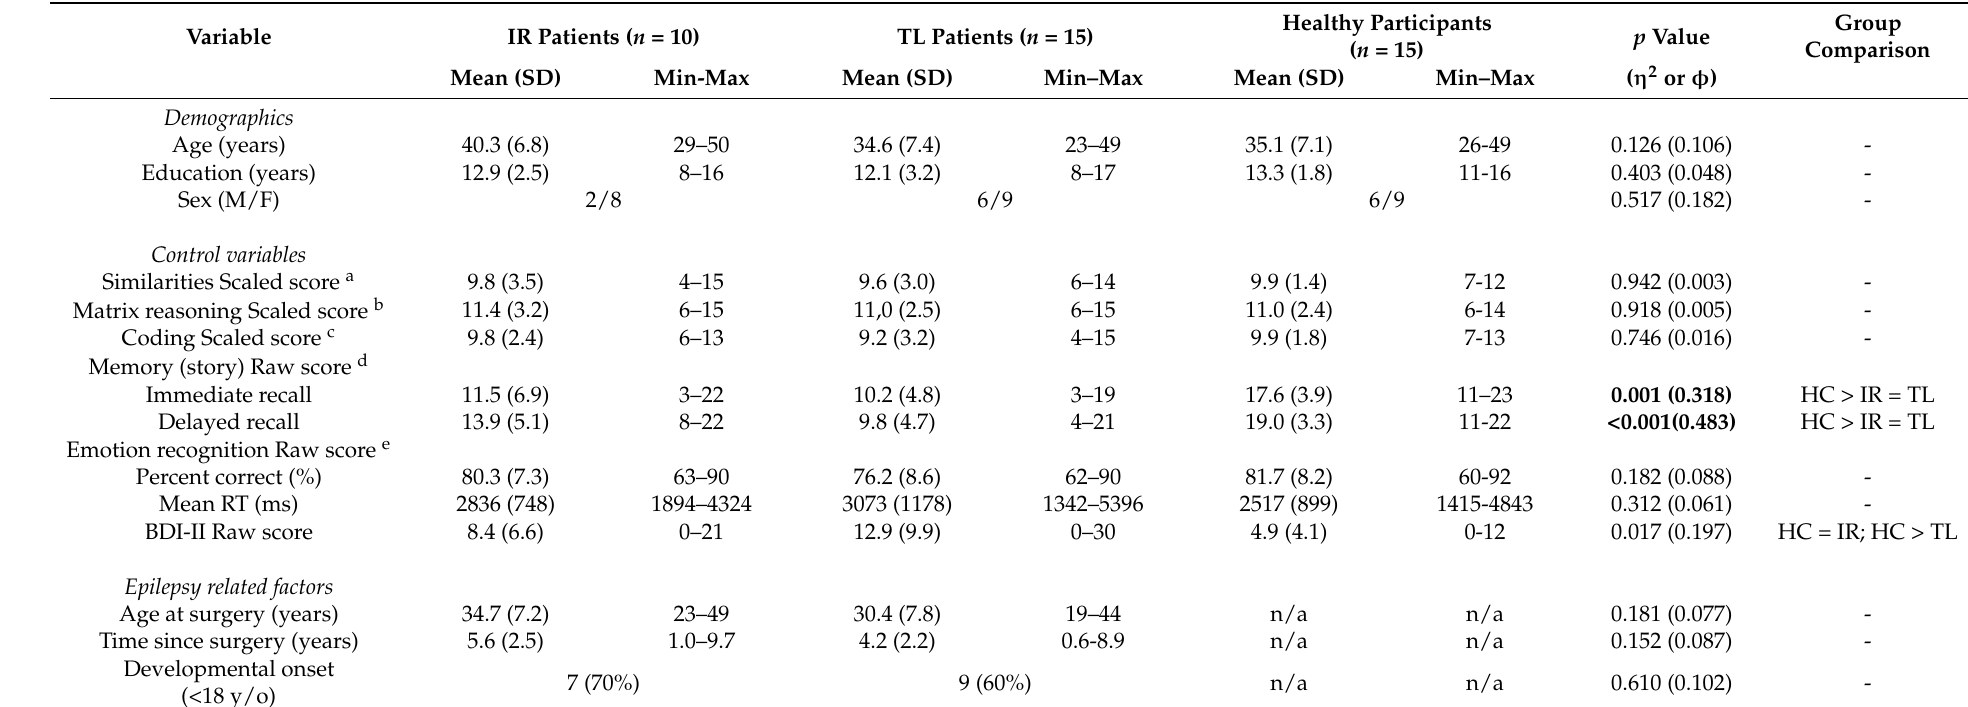
Table 4. Description of the study